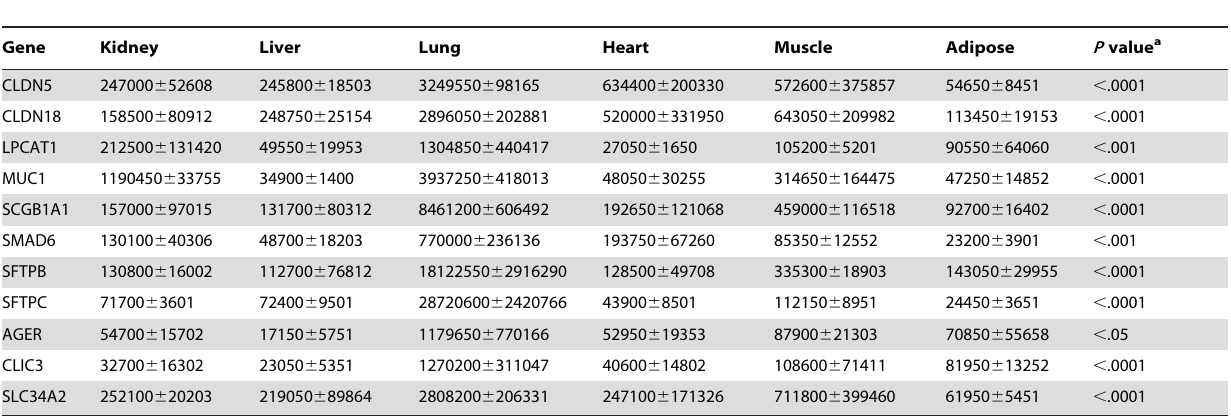
Table 6. Human lung-specific gene expression